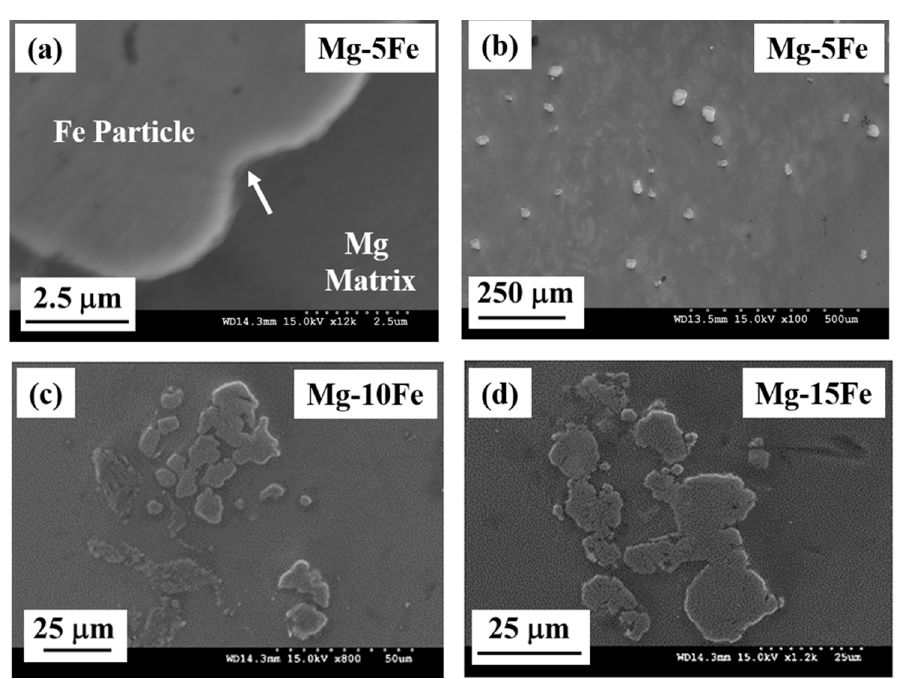
Figure 4. SEM micrographs: ( a ) clear interface in Mg-5Fe (shown by the arrow). No interfacial reaction products at interface. Distribution of Fe particles in Mg-matrix: ( b ) Mg-5Fe; ( c ) Mg-10Fe; ( d ) Mg-15Fe. Table 2. Microhardness values of pure Mg and Mg-Fe composites.